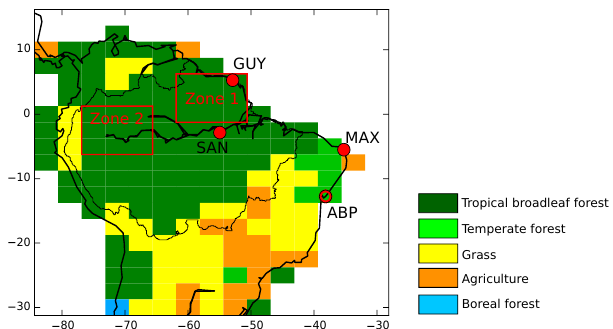
Figure 8. Dominant PFTs for each transport model grid cell (i.e. 3.75 ◦ × 2.50 ◦ ) according to the ORCHIDEE vegetation map over the study region. Open circles show location of sites with discrete air sampling; filled circles show location of sites with continuous measurements. Zones 1 and 2 indicate areas for which the NEE is presented in Fig. 7c and d